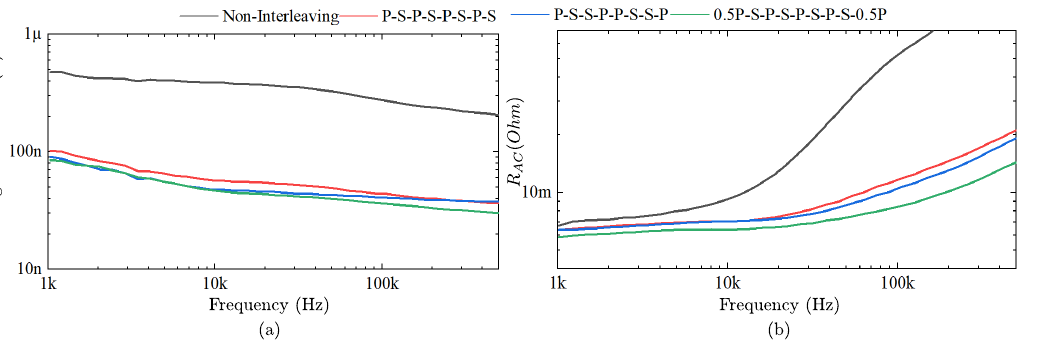
Figure 9. Comparison of the ( a ) leakage inductance and ( b ) AC resistance measurements for non- interleaved, fully interleaved (P-S-P-S-P-S-P-S), reduced intersection-interleaving (P-S-S-P-P-S-S-P), and improved-interleaved configurations (0.5P-S-P-S-P-S-0.5P). Reproduced with permission from [50], IEEE,